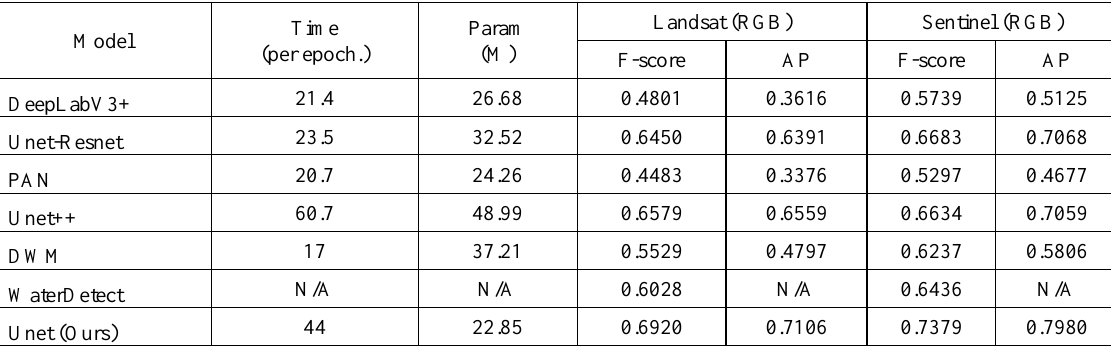
Table 2. Comparison of UNet Multiscale(Ours) against the state of the art